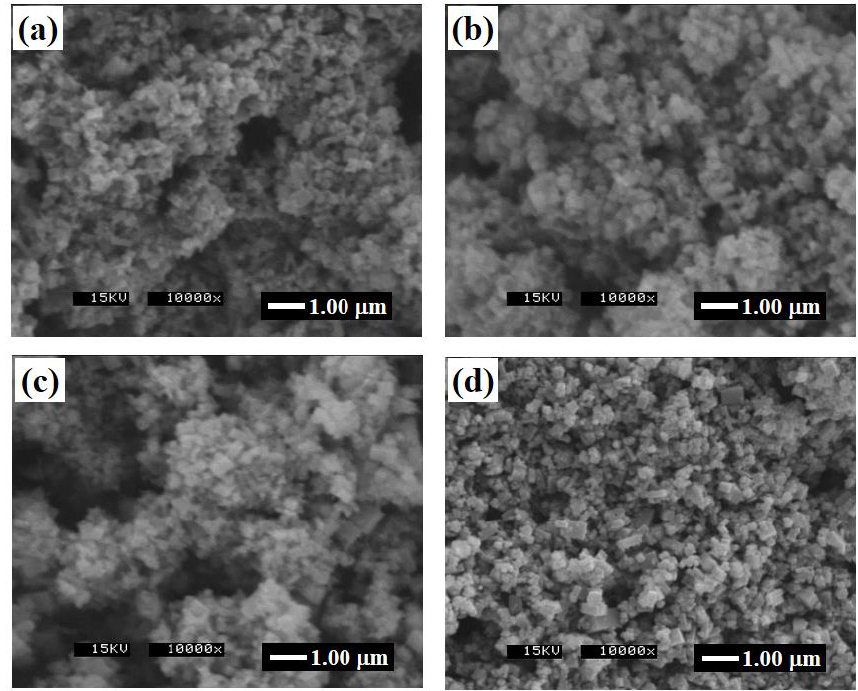
Figure 4. FE-SEM photomicrographs of KNN particles synthesized in glycothermal conditions at 200 °C with various reaction times: ( a ) 1 h, ( b ) 3 h, ( c ) 6 h, and ( d ) 12 h.